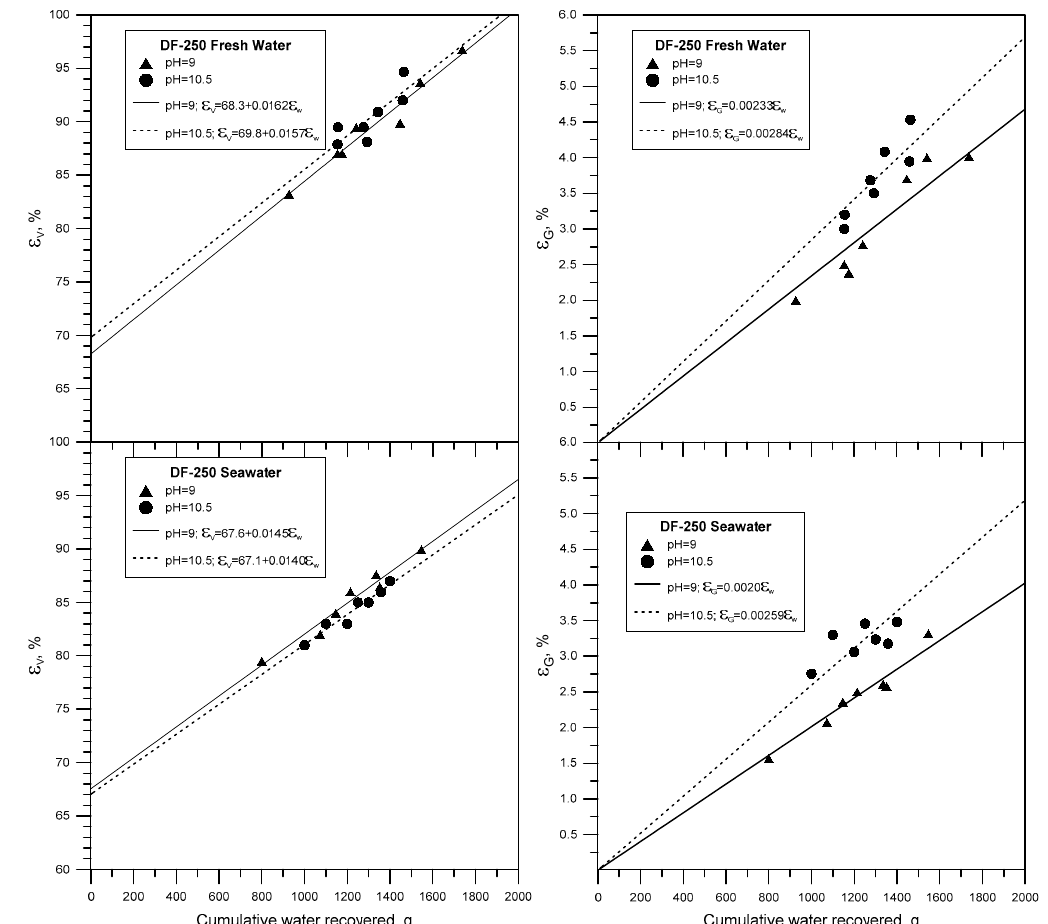
Figure 4. Recoveryofvaluable / gangueparticles( ε V / ε G )vs. cumulativewaterrecovered( ε W )usingDF-250. Figure 4. Recovery of valuable/gangue particles (  V /  G ) vs. cumulative water recovered (  W ) using DF- 250. Table 1. Constants of the Warren´s model ( Method 2 ). MIBC, methyl isobutyl carbinol.